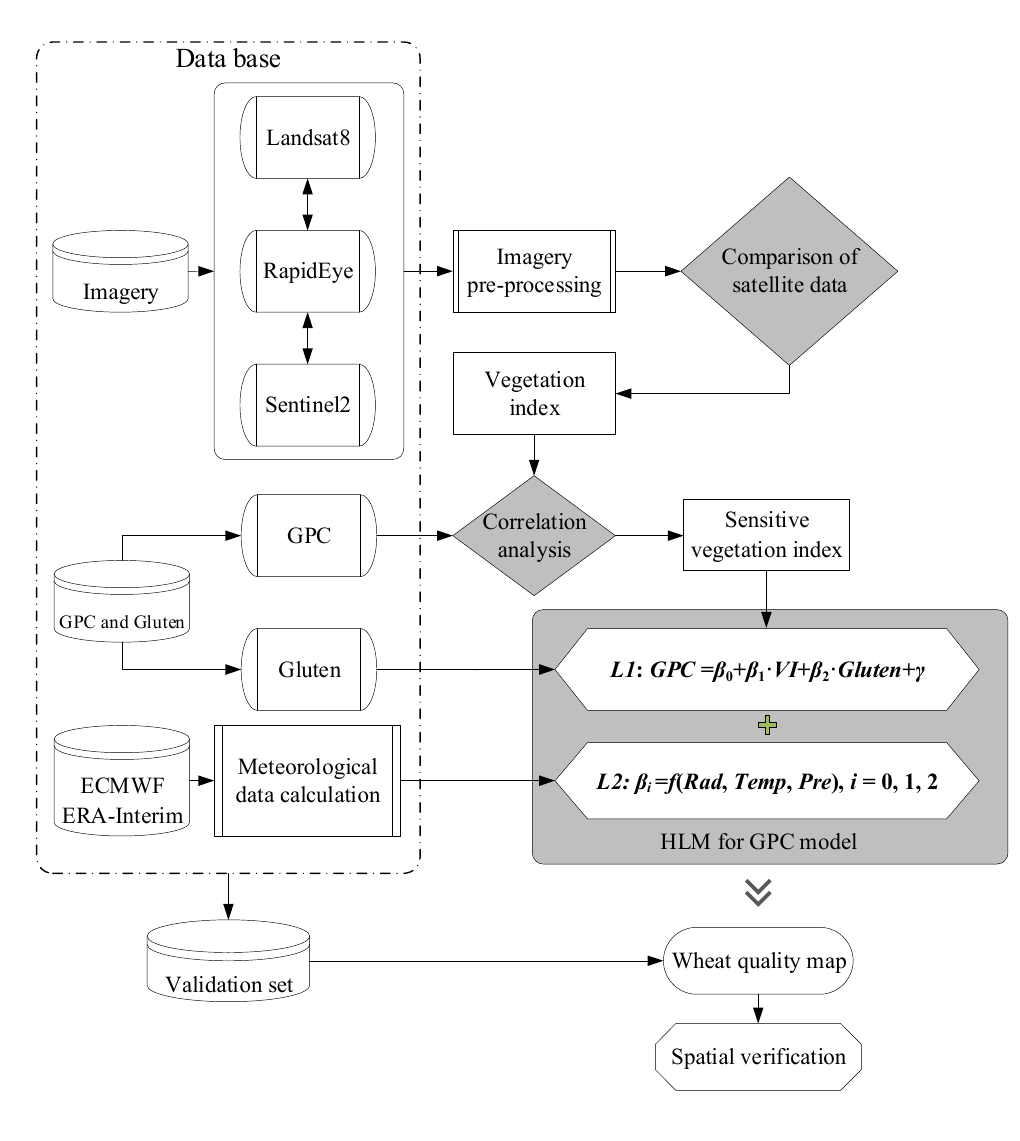
Figure 3. Flowchart of wheat grain protein content (GPC).